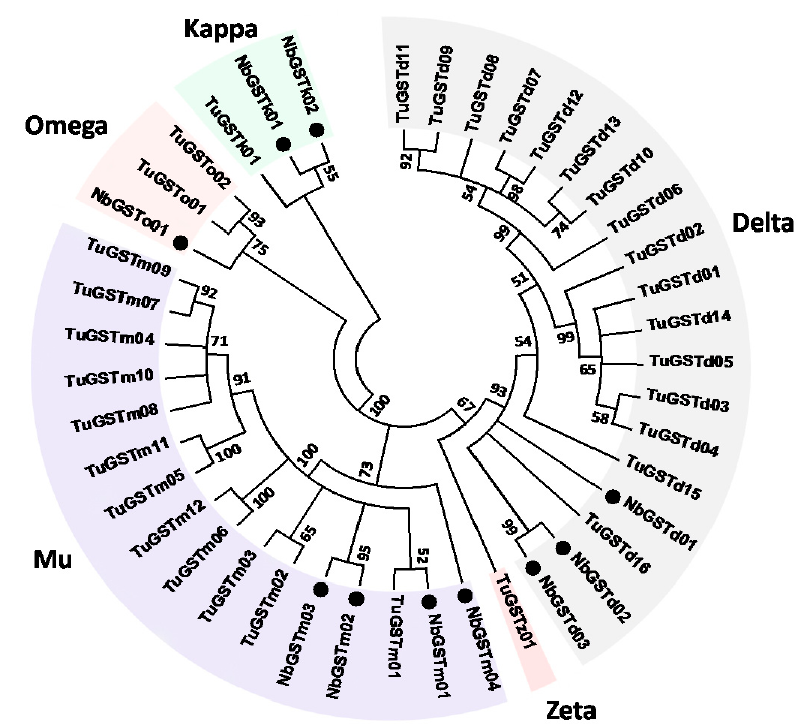
Figure 3. Neighbor-joining phylogenetic analysis of the N. barkeri GST genes. Dots represent the GST protein sequences from N. barkeri . Nb: N. barkeri ; Tu: T. urticae .